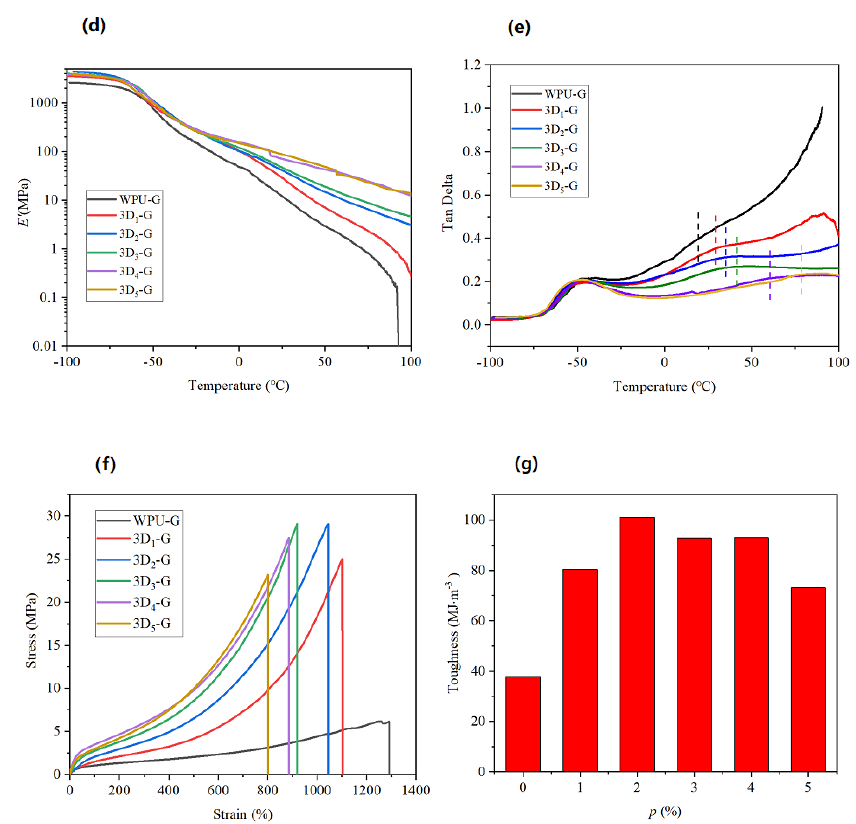
Figure 2. The effect of DMU content on WPU-G and 3D p -G ( p = 1, 2, 3, 4, 5). ( a ) Dispersion state. ( b ) FTIR spectra. ( c ) FTIR spectral peak fit in the carbonyl region (1800 to 1600 cm − 1 ). ( d ) DMA spectra of storage modulus ( E’ ) versus temperature. ( e ) DMA spectra of tan δ versus temperature. ( f ) Tensile stress–strain curve. ( g ) Fracture energy.